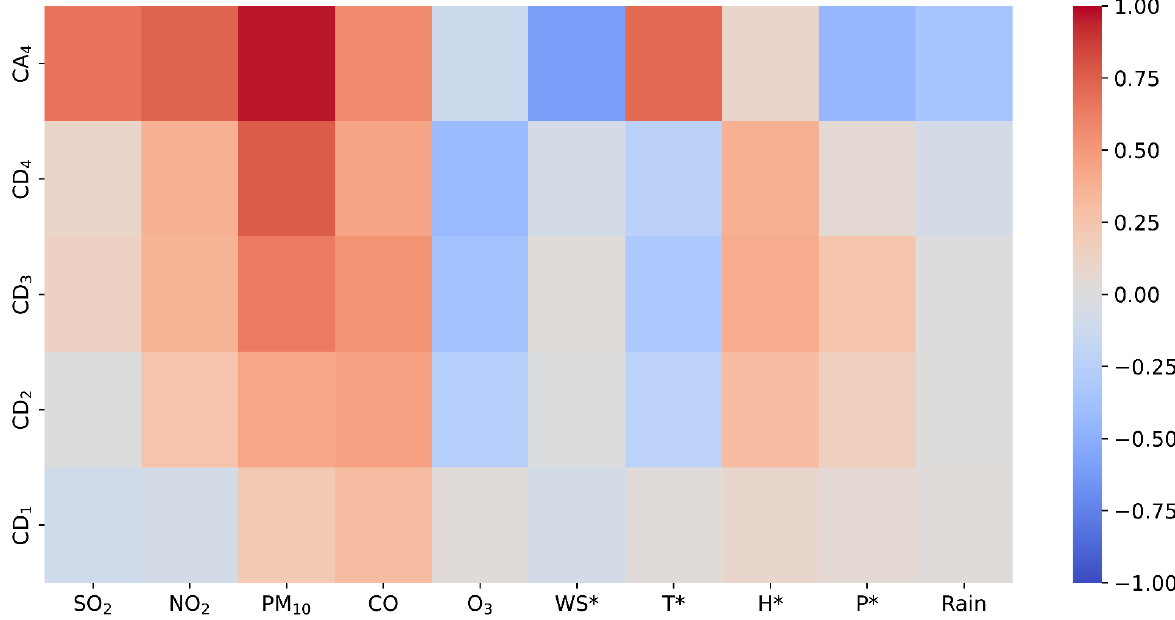
Figure 12. Correlation of PM 2.5 and other influencing factors in different frequency